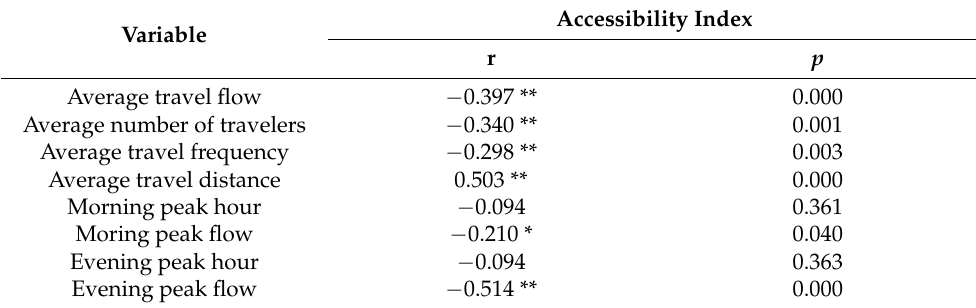
Table 7. Correlation analysis results of resident travel characteristics and accessibility index in